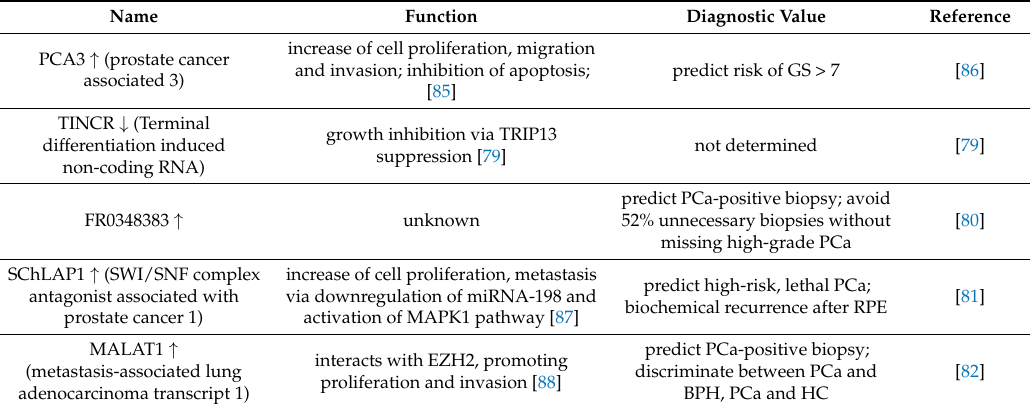
Table 3. Long non-coding RNAs (lncRNA) potential